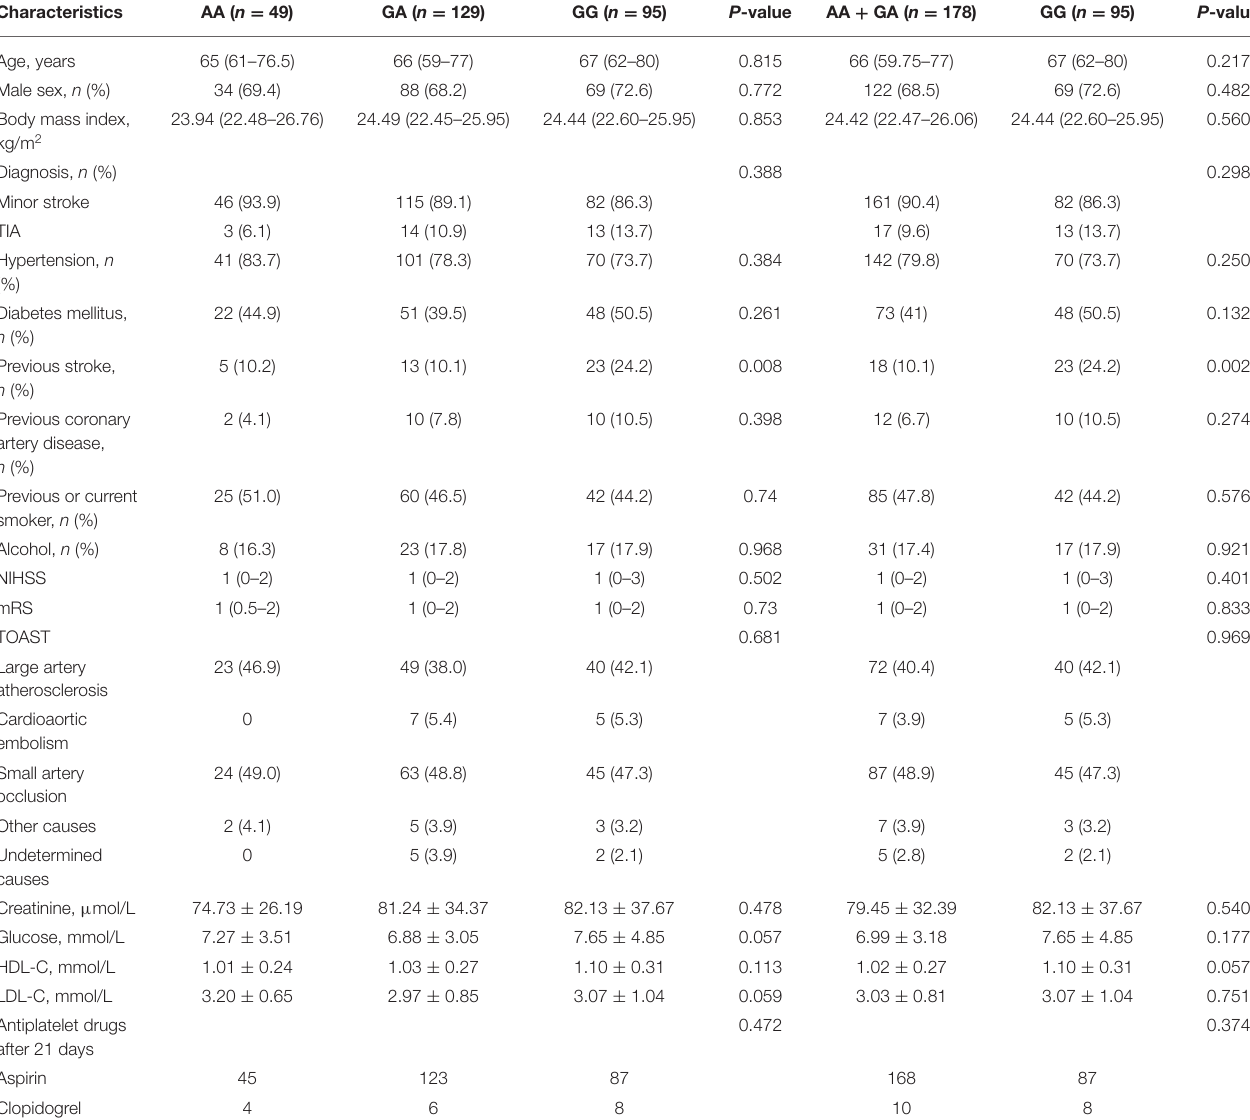
TABLE 1 | Baseline characteristics of patients with different PEAR1